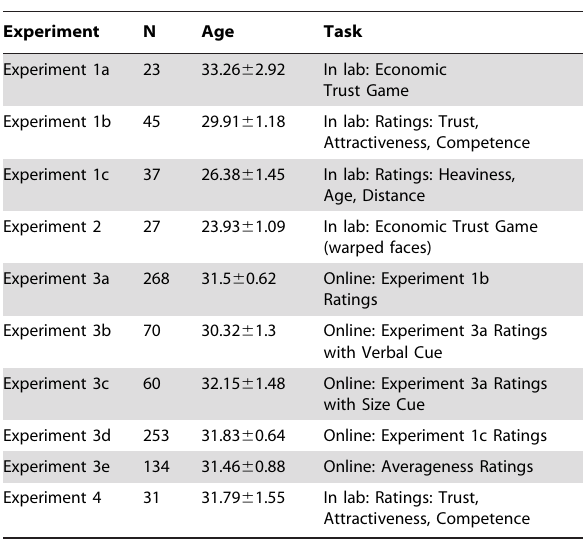
The table breaks down each experiment in terms of the number of participants (N), their age (mean and SEM) and the task used.